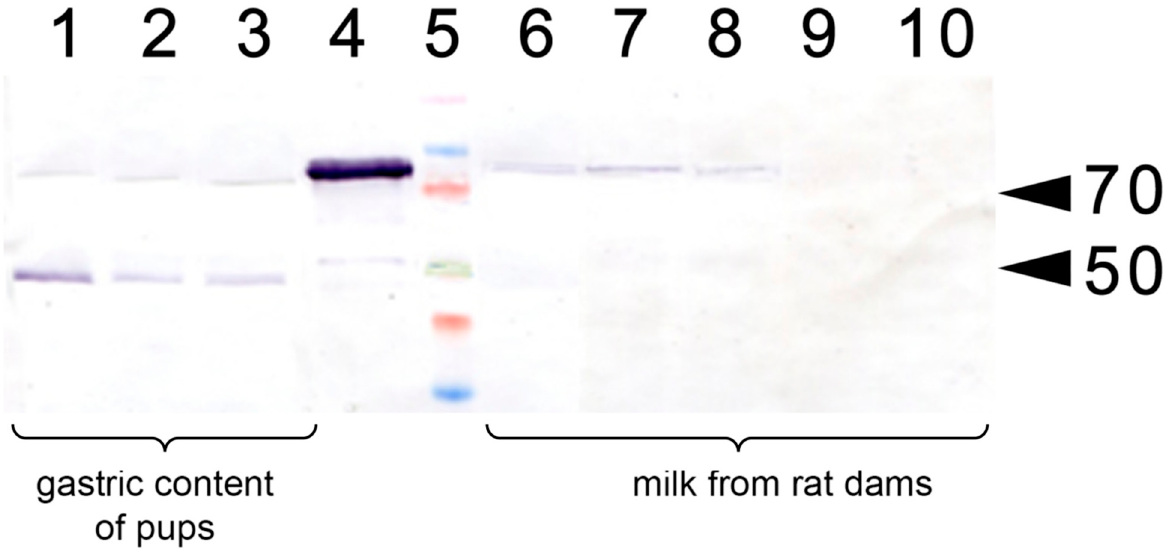
Figure 3. Western blotting with anti-LF antibody of lactating rat milk and of the gastric content of their pups. 1–3: Gastric content of pups (P14) fed by the rats injected with apo-rhLF; 4: control sample of CAPRABEL (1 µ g); 5: molecular mass markers, arrows mark 70 and 50 kDa; 6–8: milk from rats injected with apo-rhLF; 9–10 milk from control rats injected with saline.